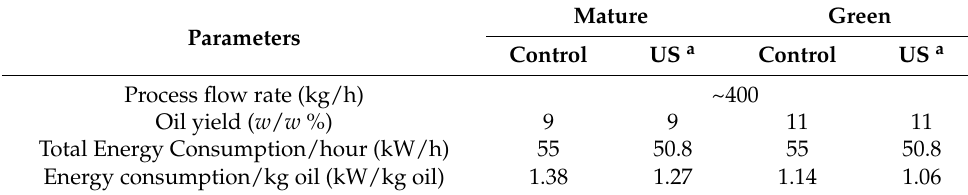
Table A1. Energy consumption: Control vs. US-assisted extractive process on Taggiasca olives. Parameters